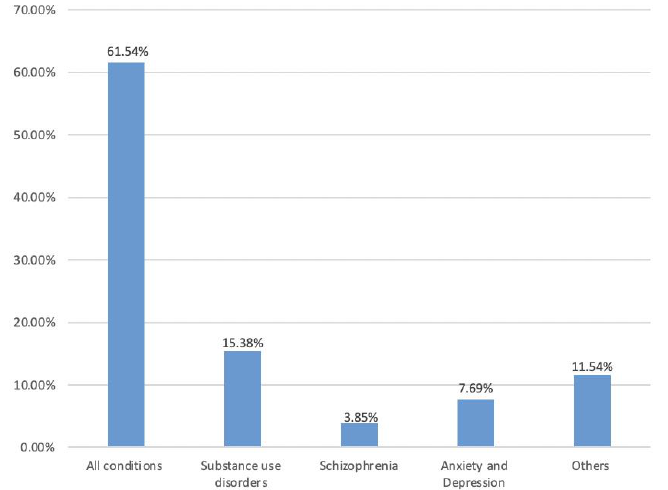
Figure 3. The percentage of studies reporting each psychological condition.